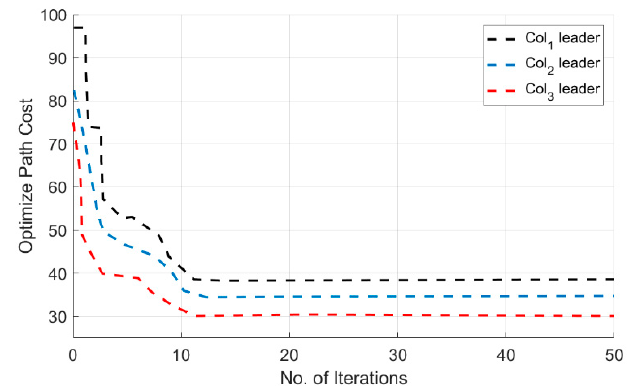
Figure 9. Optimization Costs for Case Study II.